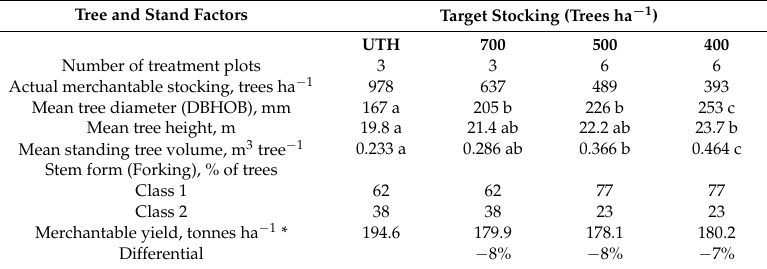
Table 2. Tree and stand factors at time of harvest. Values within a row sharing a letter were not significantly different at p = 0.05. UTH corresponds to the unthinned control